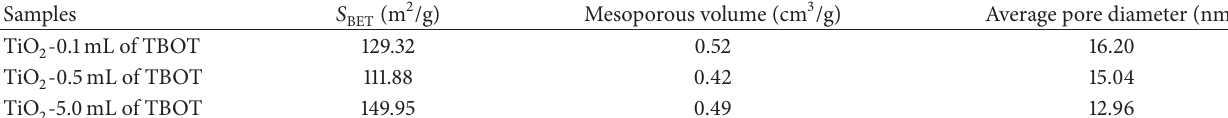
Table 1: Specific surface area and pore structure parameters of TiO 2 aerogel prepared from different concentrations of TBOT. Samples